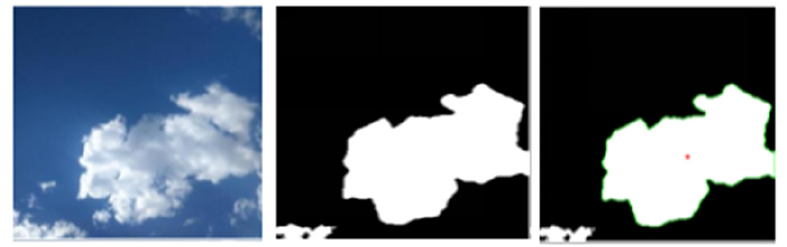
Figure 12. Cloud position data.